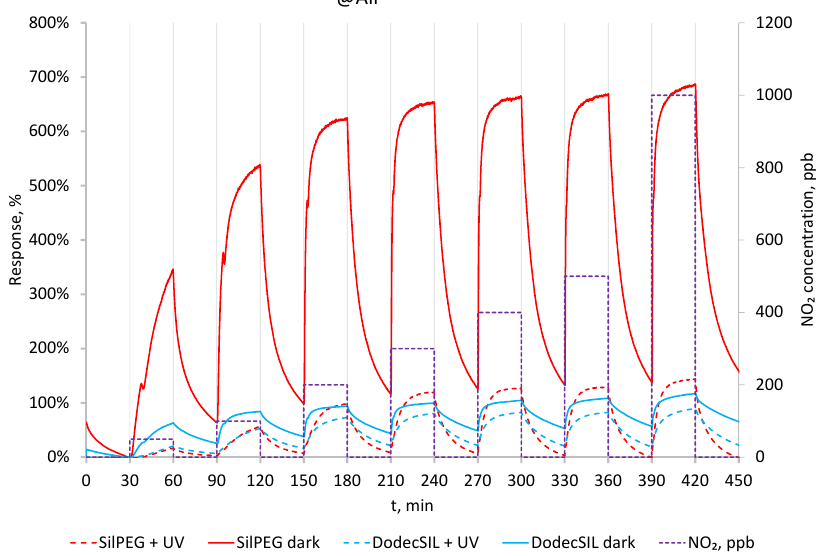
Figure 6. Response to 50–1000 ppb NO 2 in dark conditions and with UV in air at